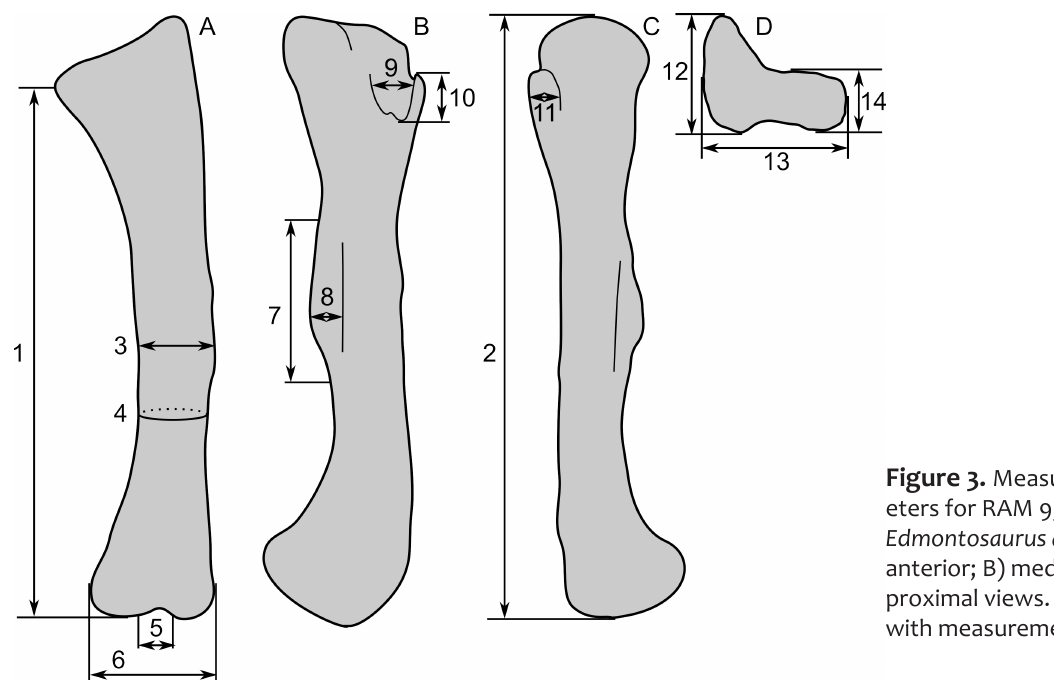
Figure 3. Measurement param- eters for RAM 9396, left femur of cf.